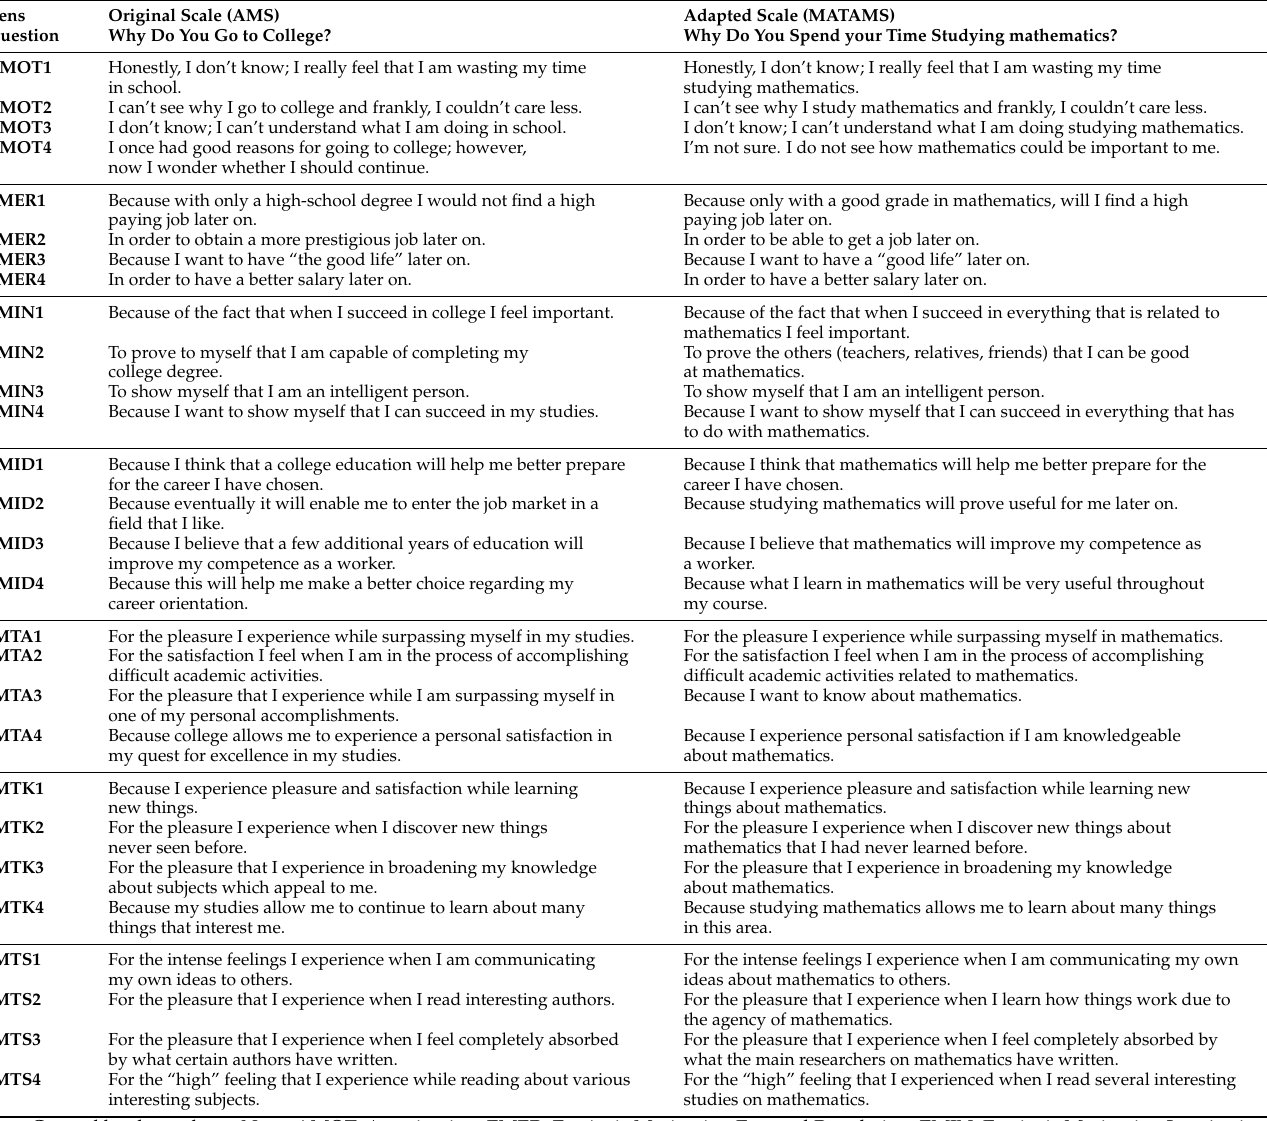
Table 2. Original and adapted items of the Academic Motivation